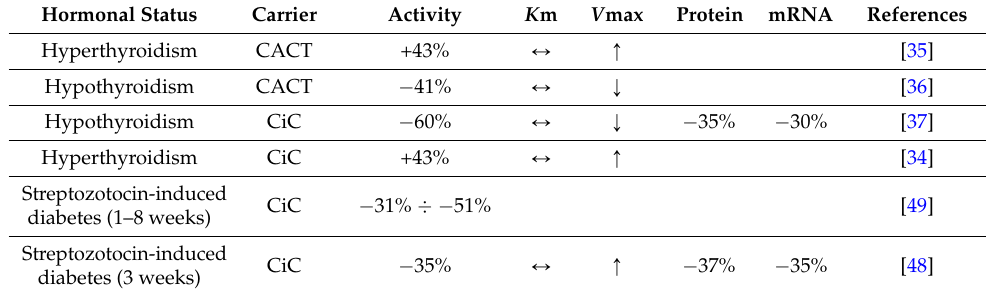
Table 1. Effect of the hormonal status on activity, kinetics, protein and mRNA levels of CACT and CiC. Hormonal Status Carrier Activity K m V max Protein